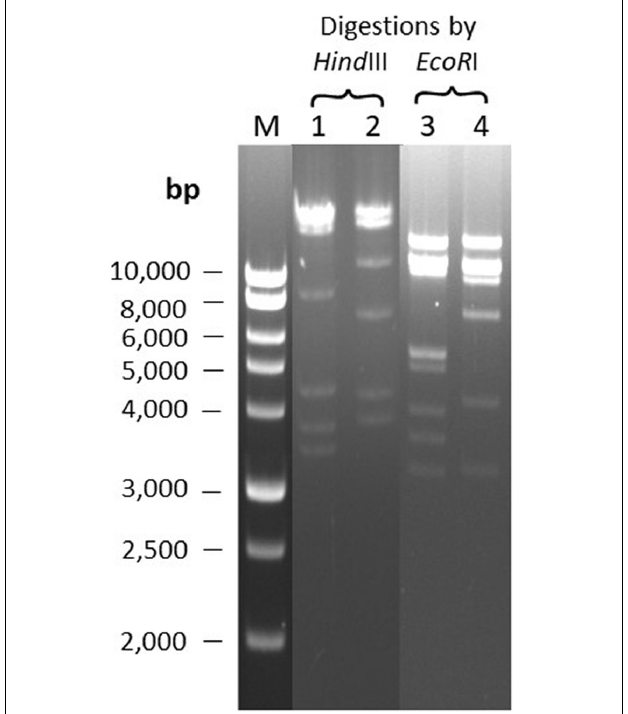
FIGURE 3 | Restriction banding patterns of phage DNAs upon digestion by endonuclease Eco RI and Hin dIII. Lane M: 1 kb ladder; Lanes 1 and 3: digestion of (cid:56) 207 DNA; Lanes 2 and 4: digestion of (cid:56) Ent DNA.